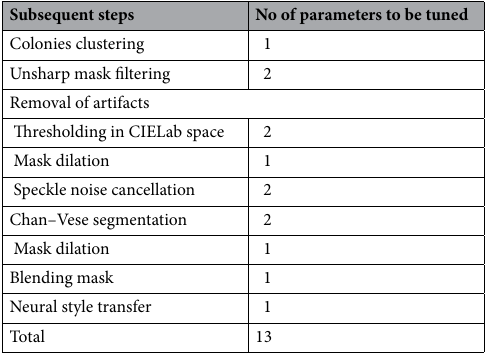
Table 1. Number of parameters (that take non-default values) for each step in the patch generation method.